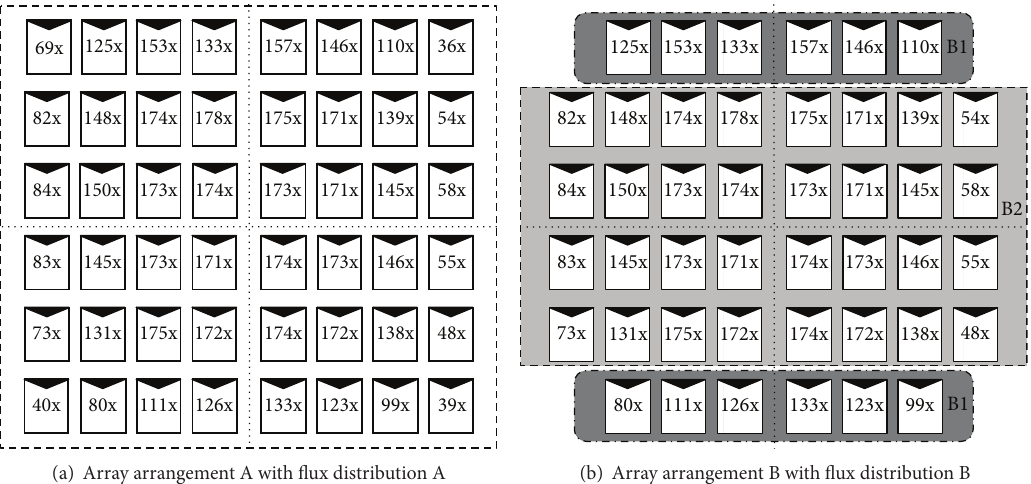
Figure 4: By using measured flux distribution data, the solar concentration ratio at each CPV cell’s location is determined. In this study, two dense-array arrangements for two flux distributions are considered, namely, (a) array arrangement A with flux distribution A and (b) array arrangement B with flux distribution B.